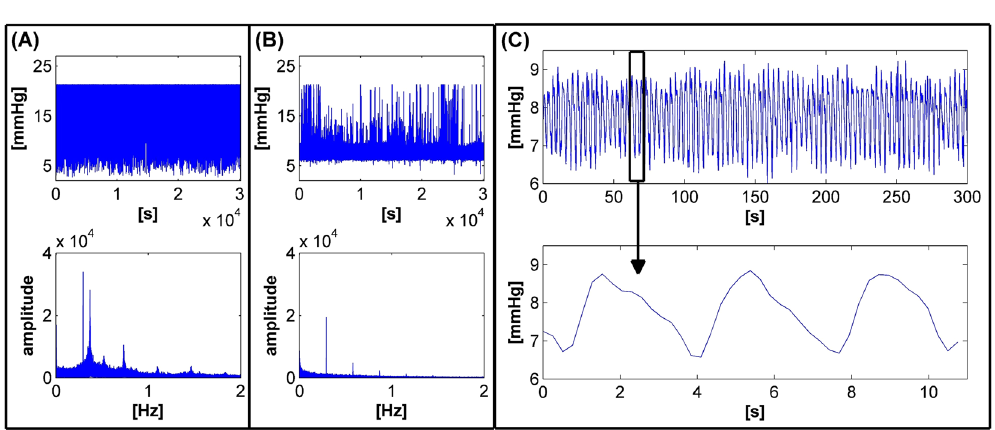
Figure 3. The trends of unexpected ( A ) and expected ( B ) acquired signals with relative Fourier transform amplitudes. Box ( C ) shows enlargements of the expected air pressure signal in the